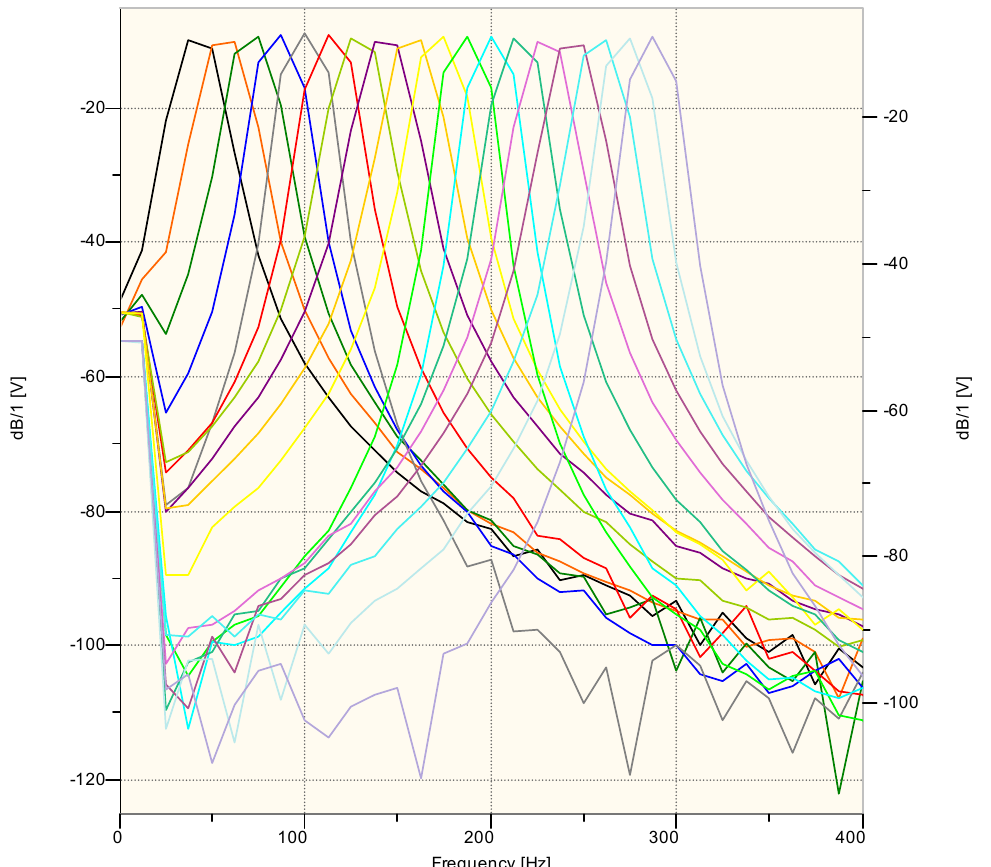
Figure 4. FFT analysis of sine sweep: 30–300 Hz; 3 s of signal; fs = 51,200 Hz; nfft = 4096 samples.